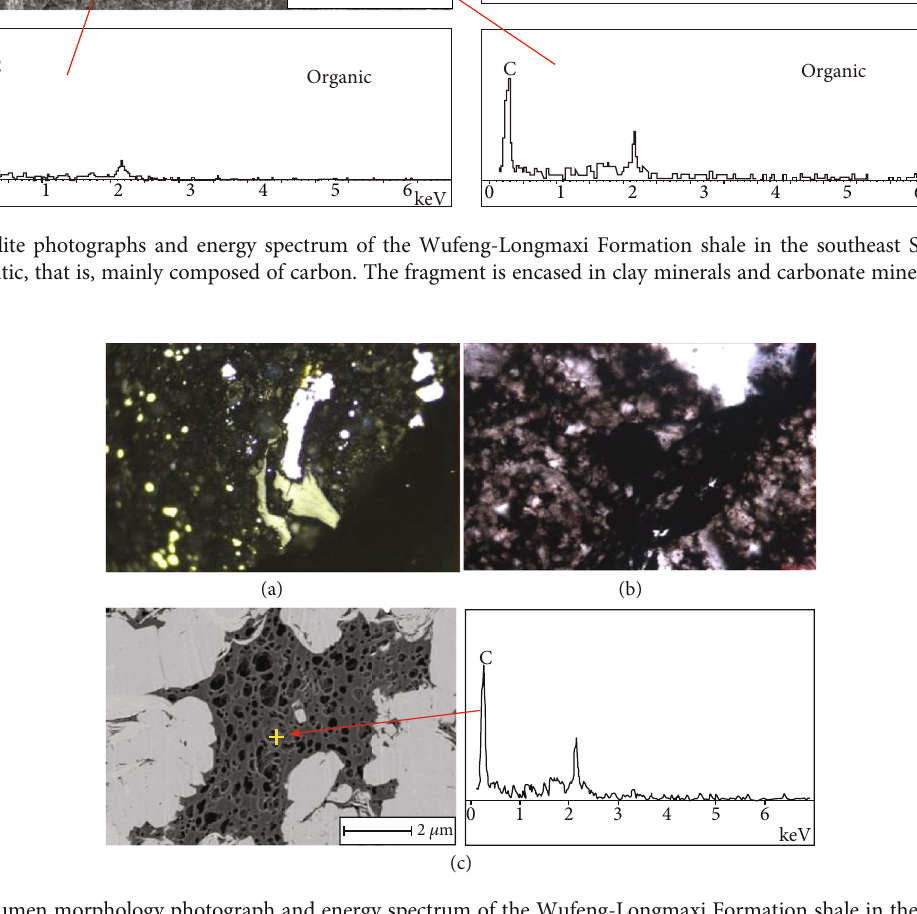
Figure 5: Pyrobitumen morphology photograph and energy spectrum of the Wufeng-Longmaxi Formation shale in the southeast Sichuan Basin. (a) Fluorescence microscope photo. (b) Polarized light microscope photo. (c) SEM photo and energy spectrum